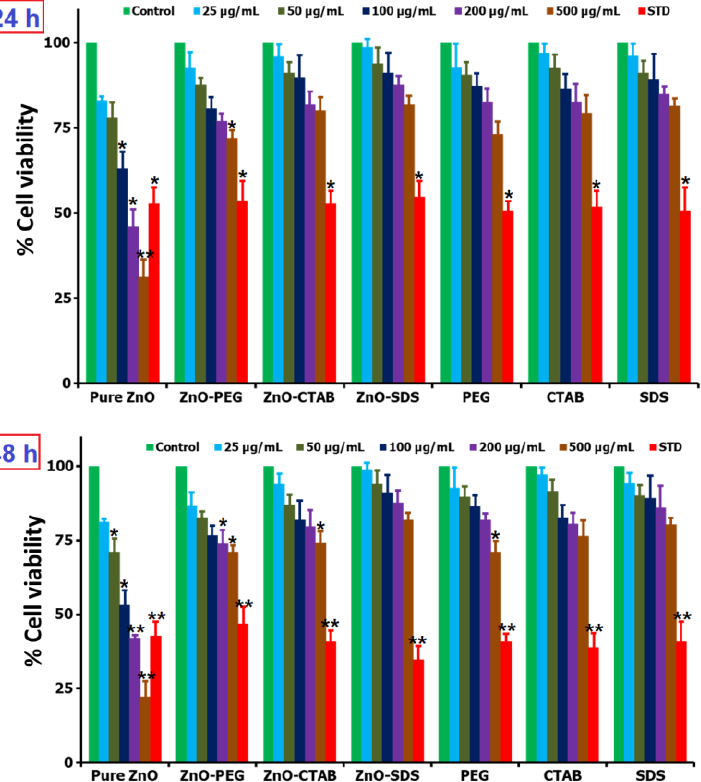
Figure 5. In vitro cell viability and proliferation studies of various ZnO NPs and surfactants (0–500 µg/mL) when tested at two different time periods of 24 and 48 h (* for significance, p < 0.05, and ** for high significance, p < 0.01).